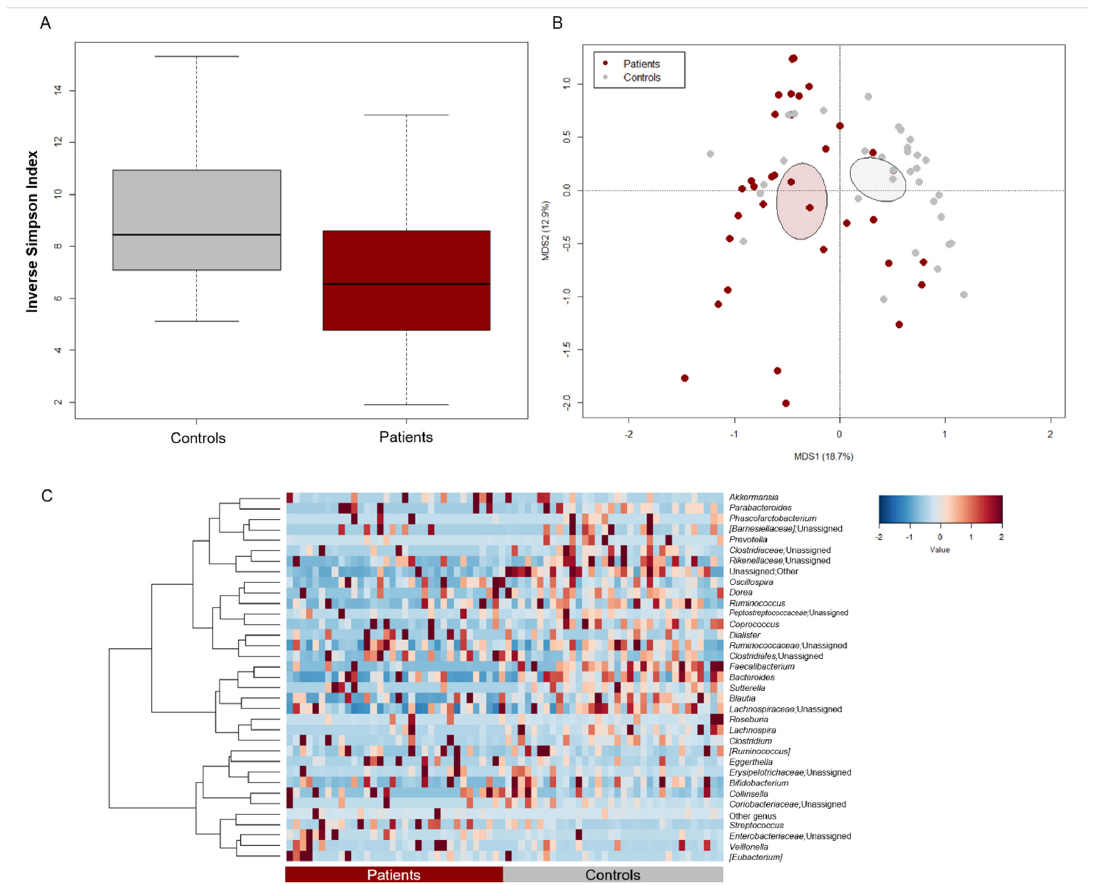
Figure 1. Gut microbiota structure of pediatric patients with hematological malignancies compared to healthy controls. ( A ) Boxplots showing the distribution of alpha diversity, estimated with the inverse Simpson index, in pediatric patients with hematological malignancies vs. age/sex/BMI-matched healthy controls from previous studies [38–40]. Patients were characterized by significantly less diversity (Wilcoxon test, p = 0.008). ( B ) PCoA based on Bray–Curtis dissimilarities between the gut microbiota profiles of patients and controls. Ellipses include 95% confidence area based on the standard error of the weighted average of sample coordinates. A significant separation between groups was found (permutation test with pseudo-F ratio, p = 0.001). ( C ) Heatmap showing Ward- linkage clustering based on Pearson’s correlation coefficients of the relative abundance of genera from patients and controls. Only taxa with relative abundance > 1% in at least 6 samples are